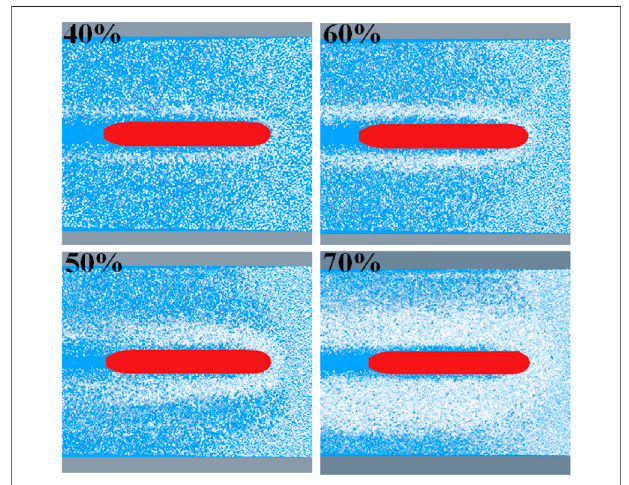
FIGURE 19 | Brash ice channels of different